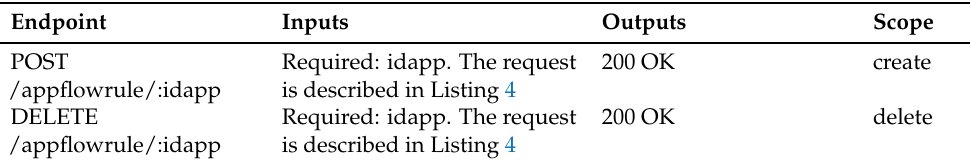
Table 5. API endpoint specification: appflowrule.